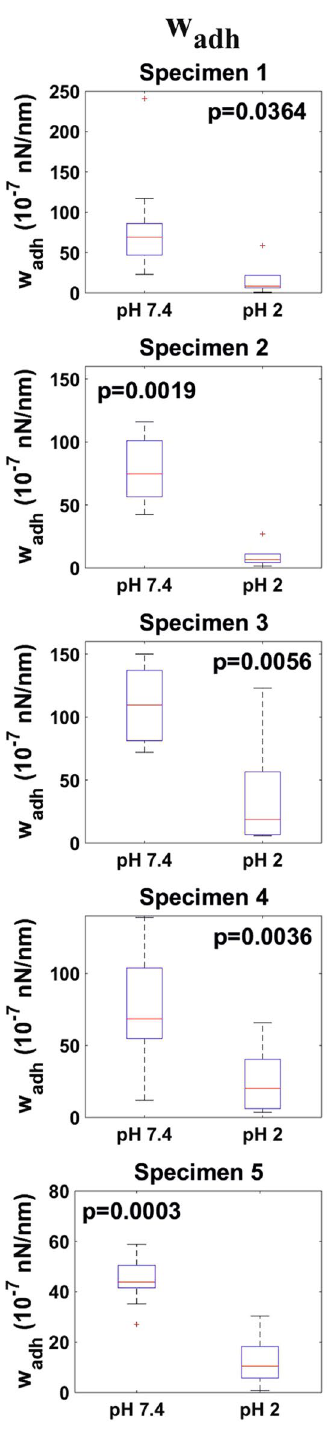
Figure 8. Distributions (n = 10) of wadh values obtained at both pH 7.4 and pH 2 for all investigated